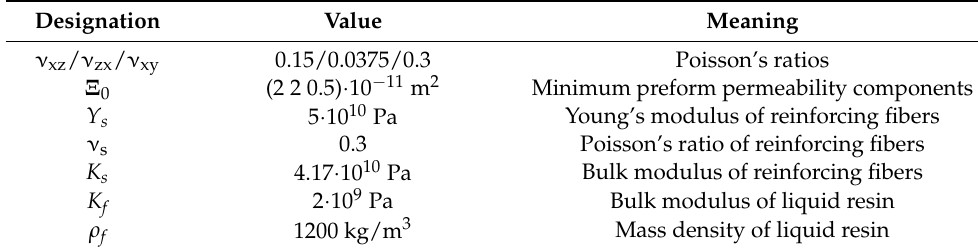
Table 1. Properties of the modeled system components.